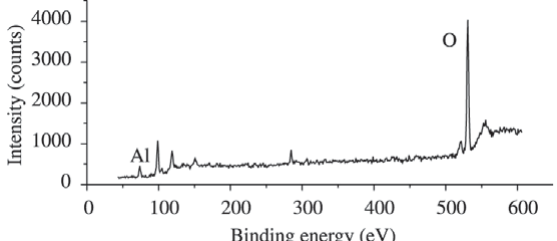
Figure 6. X-ray photoelectron spectra of coating Ti